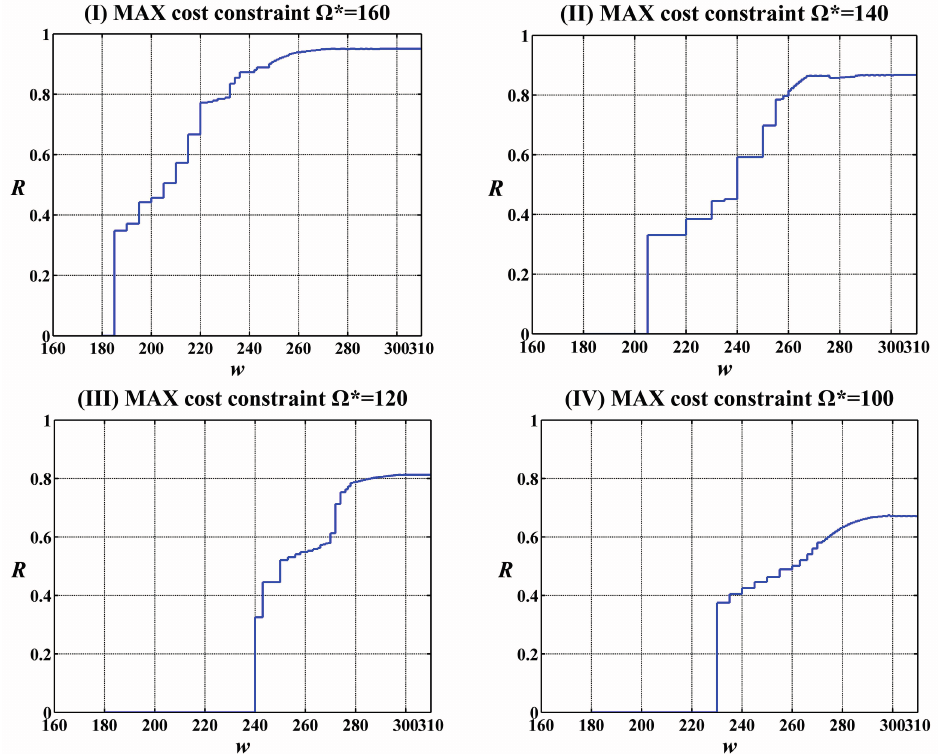
Figure 7. Change of the values of reliability function R ( w * ) along with the execution time w under the given expected execution time w * =